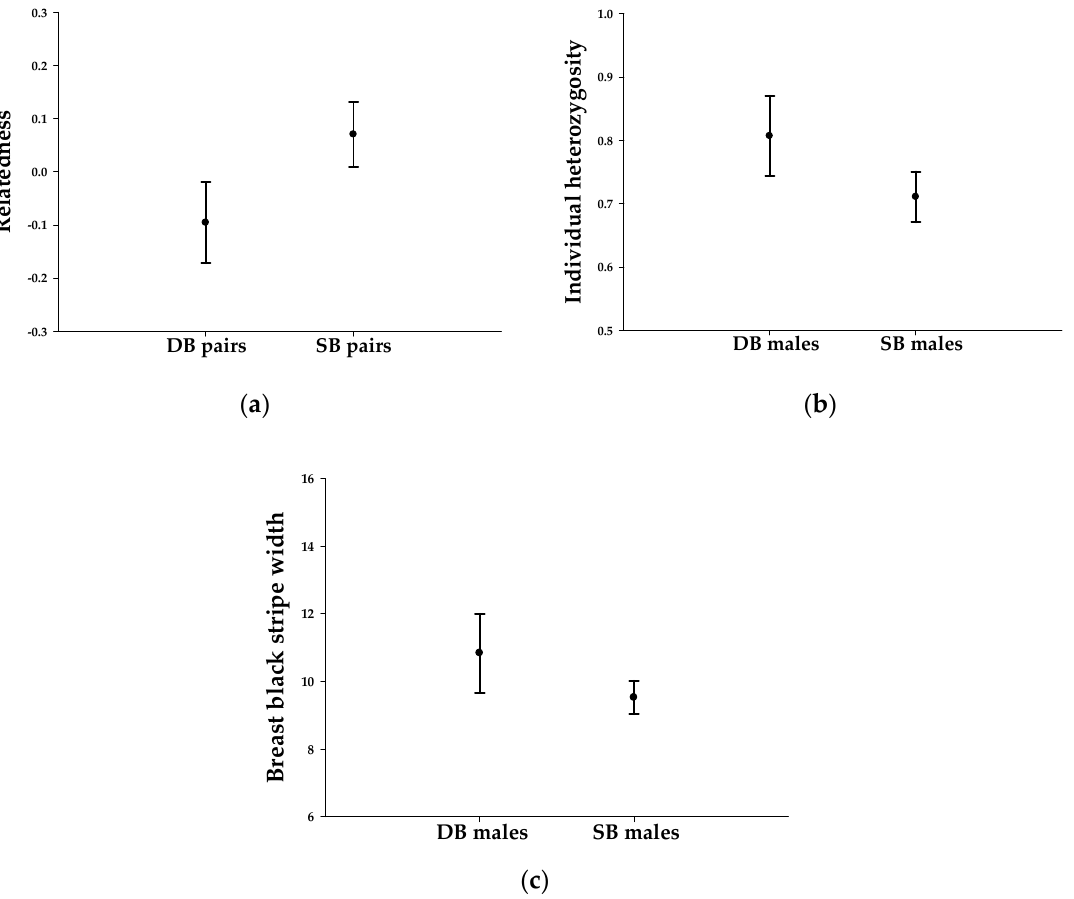
Figure 2. ( a ) Relatedness of double-breeding (DB) and single-breeding (SB) pairs; ( b ) individual heterozygosity for double-breeding (DB) and single-breeding (SB) males; and ( c ) breast black stripe width for double-breeding (DB) and single-breeding (SB) males: the results are presented as the means and upper–lower 95% confidence intervals for each group.